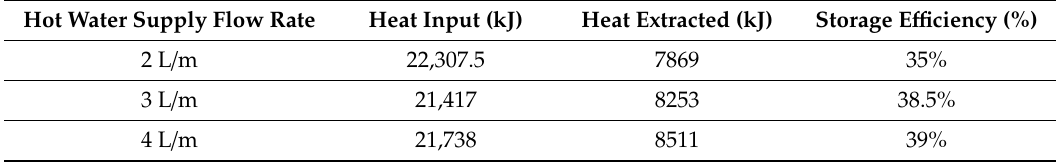
Table 3. Tank storage e ffi